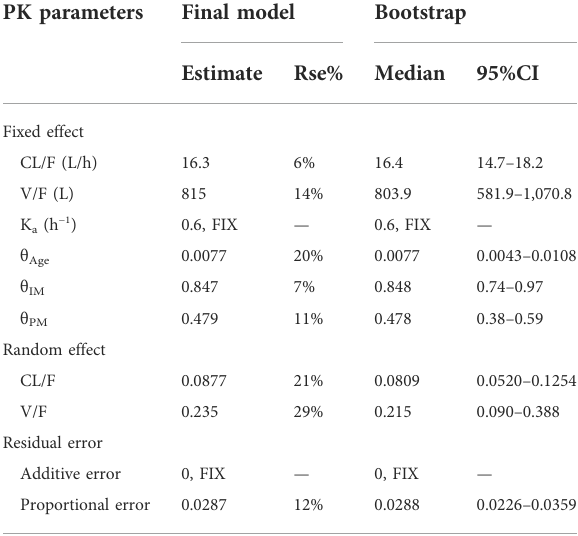
TABLE 4 Final parameter estimates of escitalopram PopPK model.